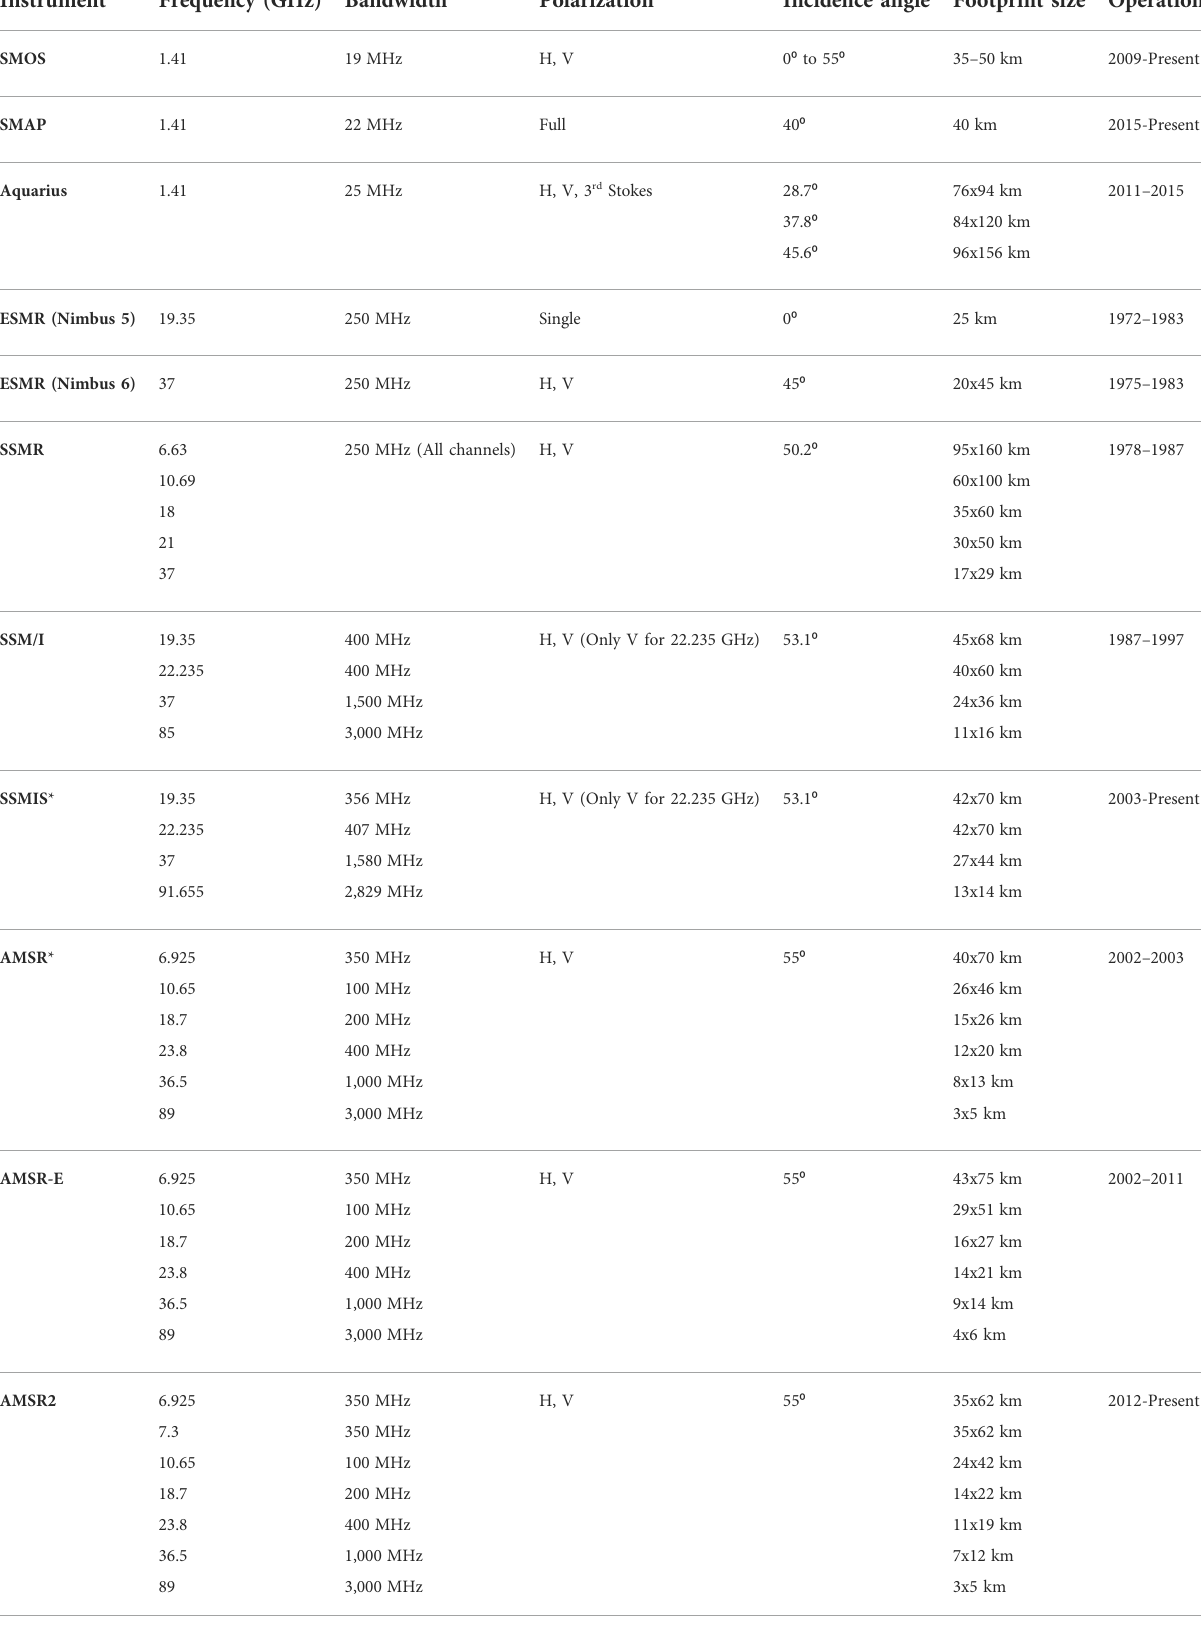
TABLE 1 Instrument Parameters of spaceborne